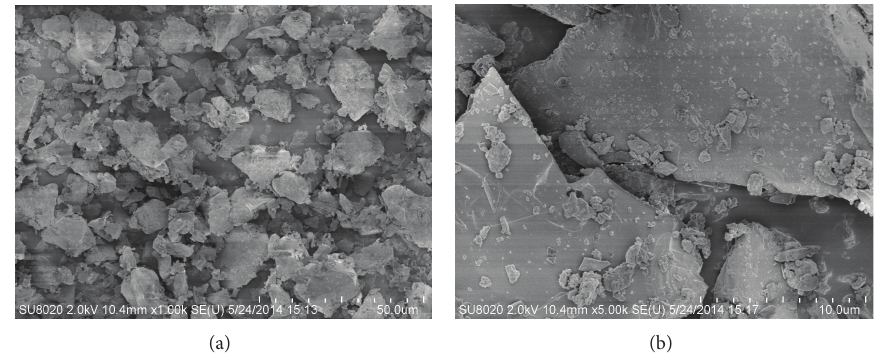
Figure 2: SEM images of the BaLa 2 ZnO 5 :0.05Er 3+ /0.10Yb 3+ plotting scale × 1000 (a) and plotting scale × 5000 (b).